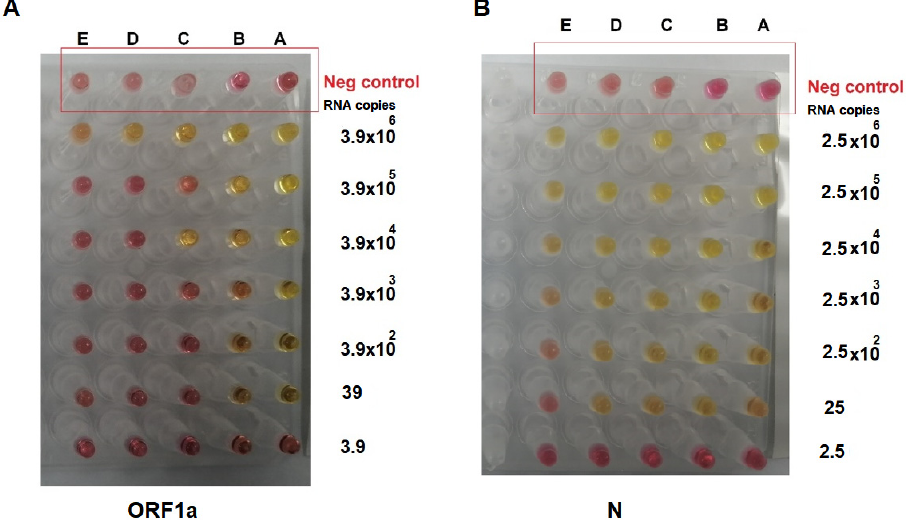
Figure 7. RT-LAMP assay on synthesized RNA molecules, showing ( A ) the RT-LAMP assay performed on synthesized RNA from the ORF1a gene and ( B ) the RT-LAMP assay performed on synthesized RNA from the N gene. The RNA molecules were serially diluted tenfold, and the reaction was incubated in the heat block at 65 °C for 30 min. The pink color indicated a negative reaction, while the yellow indicated a positive one. The RT-LAMP assay was highly sensitive as it detected 39 copies for ORF1a (primers A and B) and 25 copies for the N gene (primers A–D).